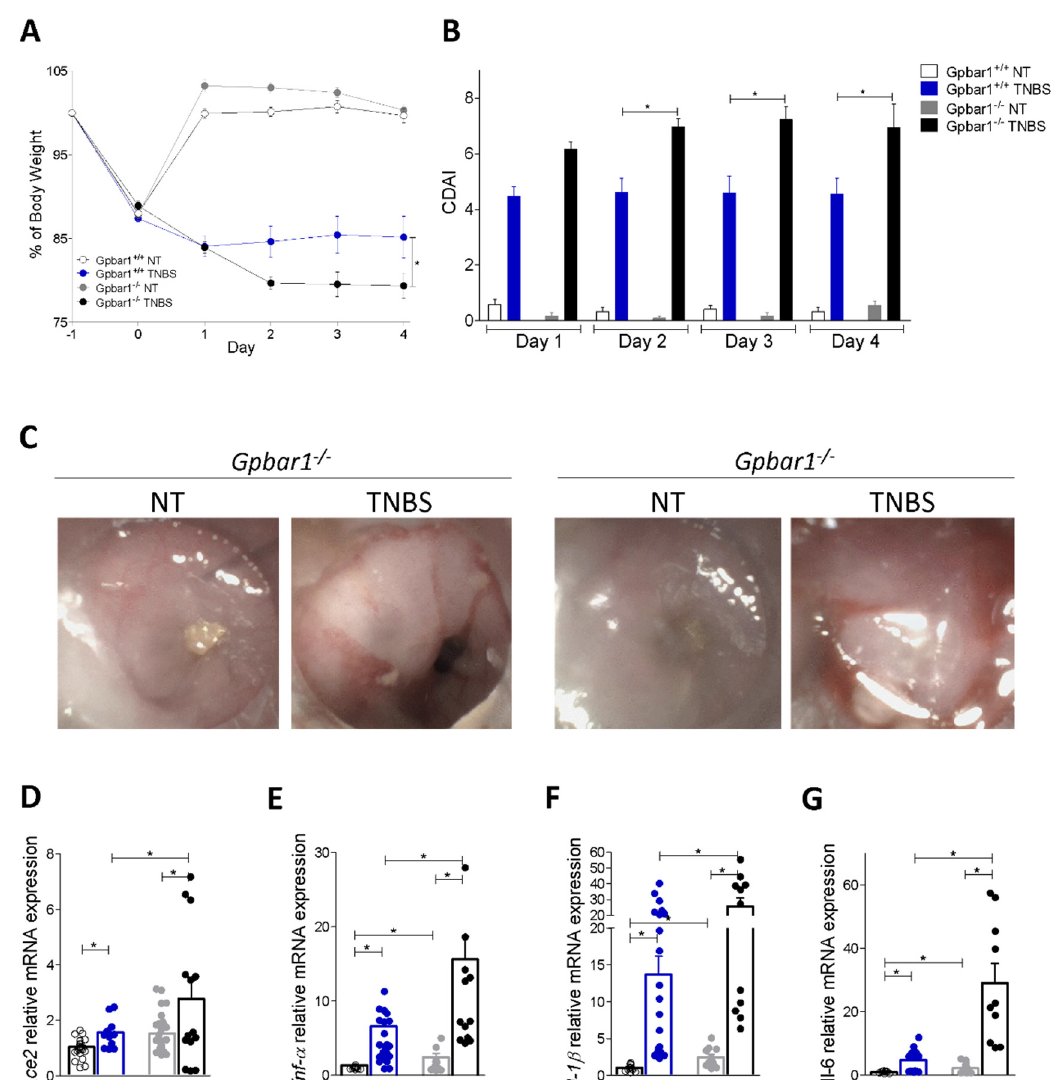
Figure 4. The lack of Gpbar1 increases upregulation of Ace2 in inflamed mouse colons. C57BL/6 male mice (Gpbar1 +/+ ) and their congenic littermates Gpbar1 knock out (Gpbar1 − / − ) were treated with TNBS as described above. Data shown are: ( A ) changes in body weight and ( B ) Colitis Disease Activity Index (CDAI) of mice during the course of TNBS-induced colitis. ( C ) Representative endoscopic pictures showing the colon of Gpbar1 +/+ and Gpbar1 − / − healthy mouse and treated with TNBS. Relative mRNA expression levels of ( D ) Ace2 and pro-inflammatory genes ( E ) Tnf- α , ( F ) Il-1 β , and ( G ) Il-6. Data are normalized to Gapdh mRNA. Results are the mean ± SEM, each point represents a mouse; * p < 0.05.